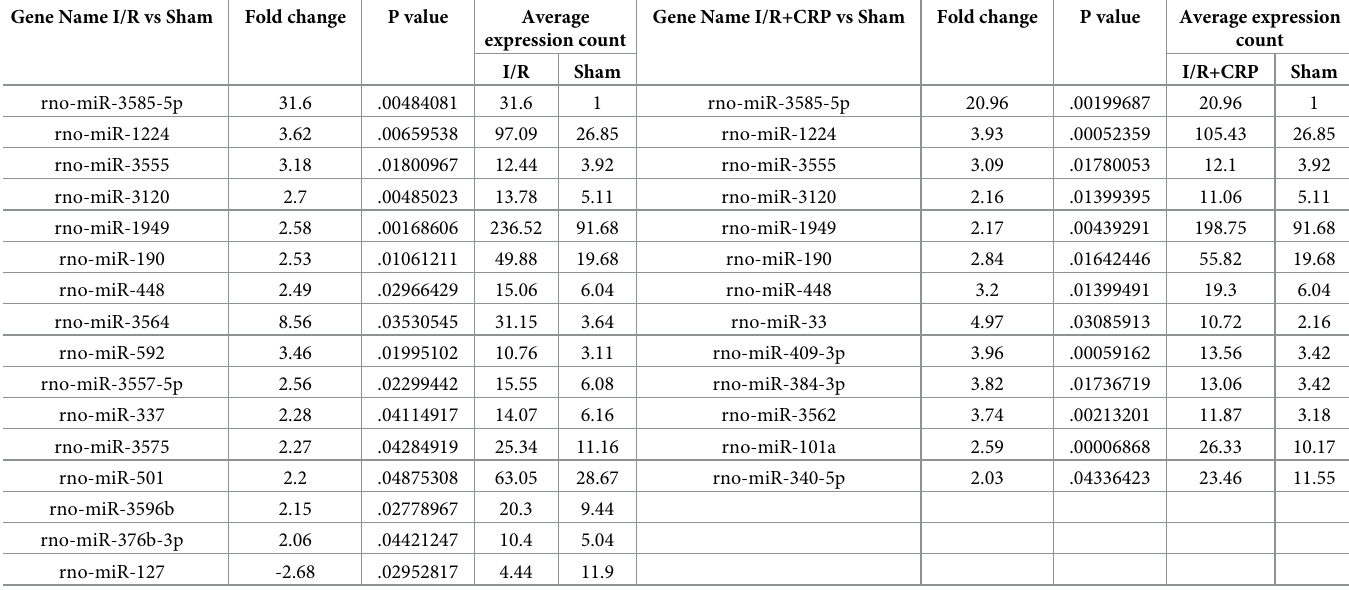
Table 1. Genes significantly changed in each group compared to the sham group in ischemic but viable myocardium (red area by evans blue and TTC staining). Gene Name I/R vs